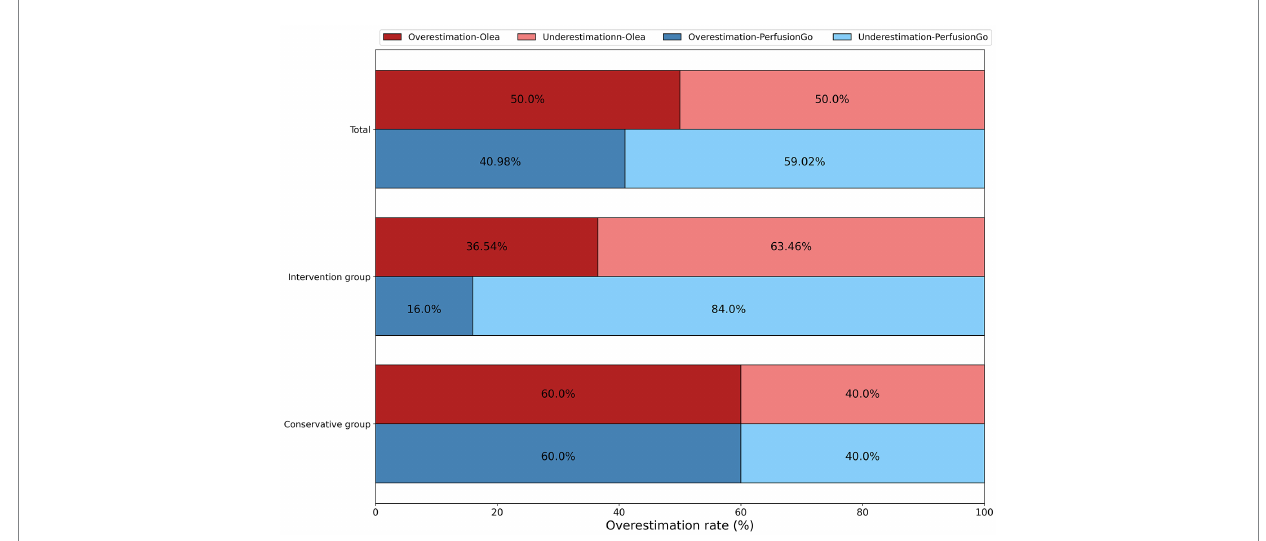
FIGURE 3 Overestimation of infarct volume by both software as compared with the true final infarct volume